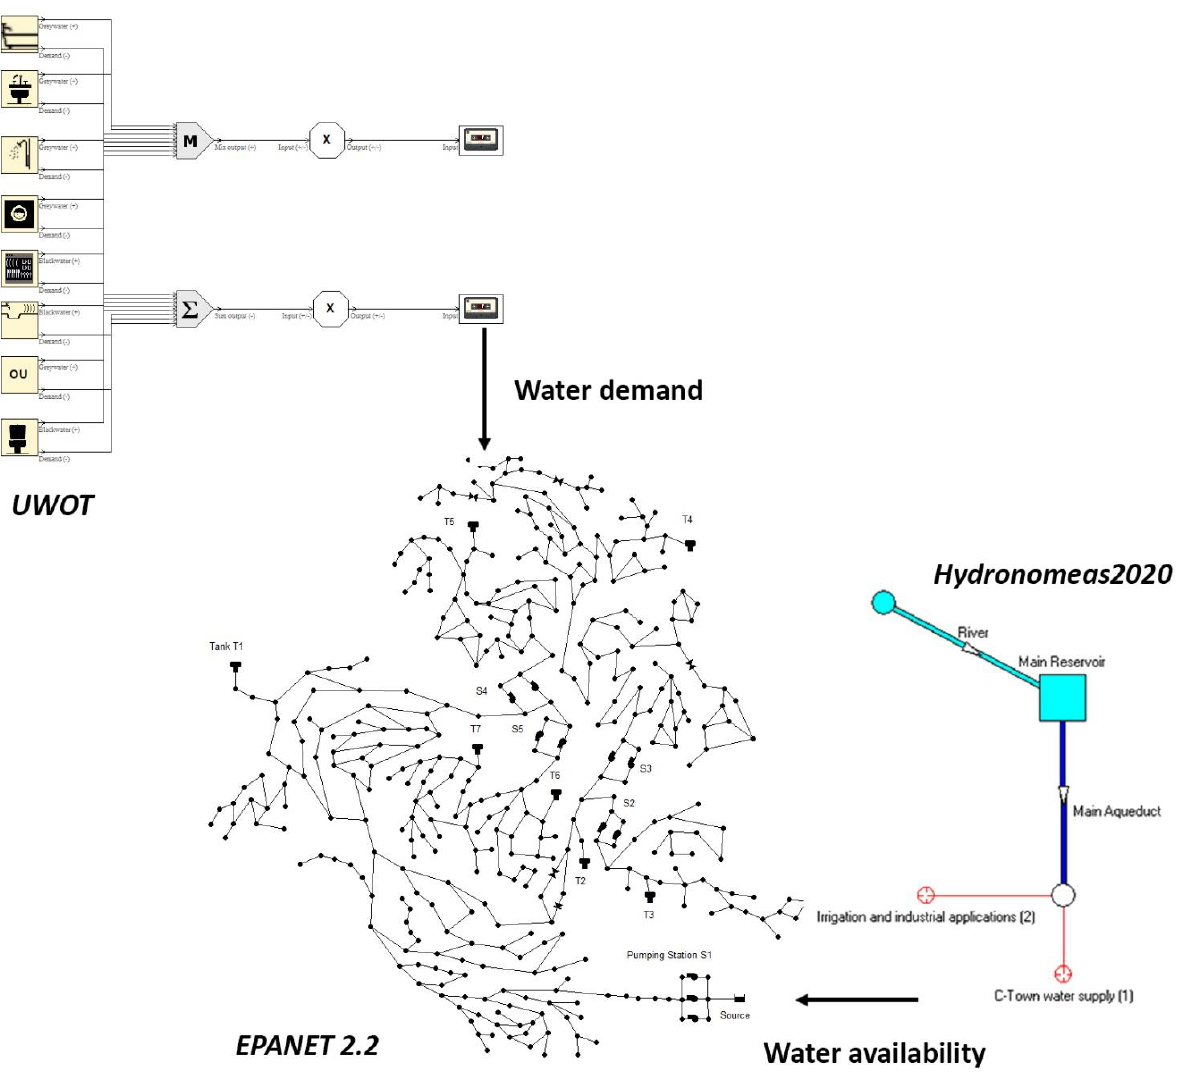
Figure 1. Coupling the computational models within a source-to-tap simulation scheme.